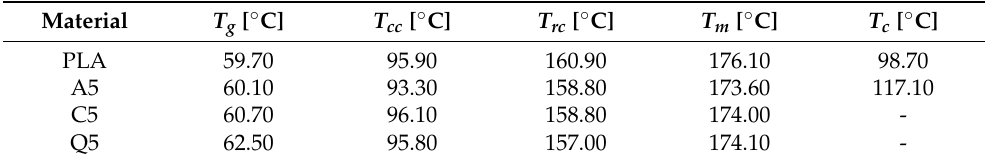
Figure 13. DSC thermograms of PLA and its composites containing 5% ( w / w ) of alizarin (A5), curcumin (C5), or quercetin (Q5) during ( a ) the heating cycle and ( b ) the cooling cycle. Table 4. Thermal transition temperatures of PLA and its composites containing 5% ( w / w ) of alizarin (A5), curcumin (C5), or quercetin (Q5).